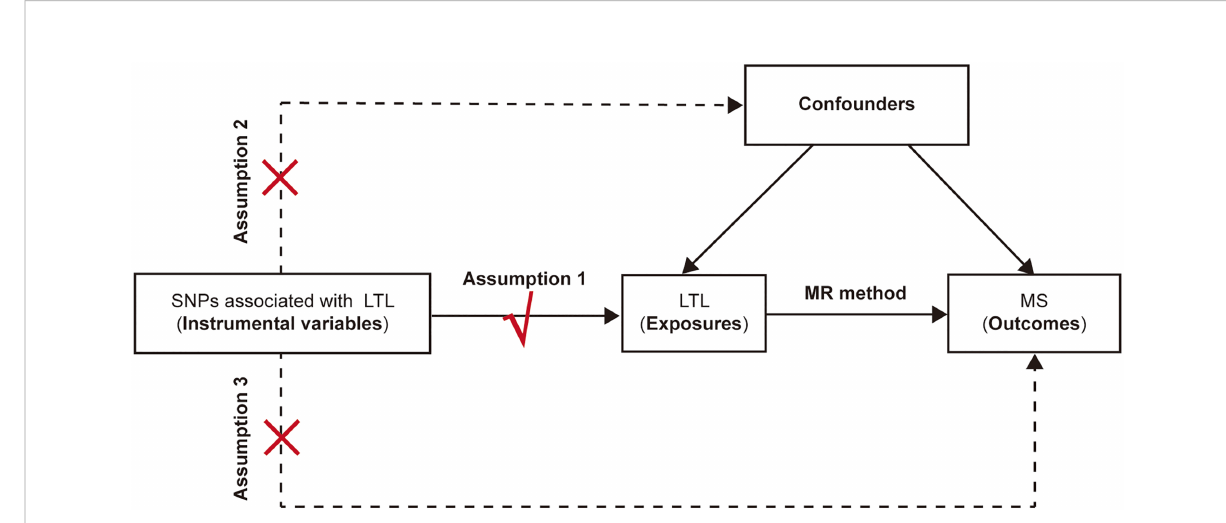
FIGURE 1 The schematic diagram for the Mendelian randomization analysis. SNP, single-nucleotide polymorphism; LTL, leukocyte telomere length; MR, Mendelian randomization; MS, multiple